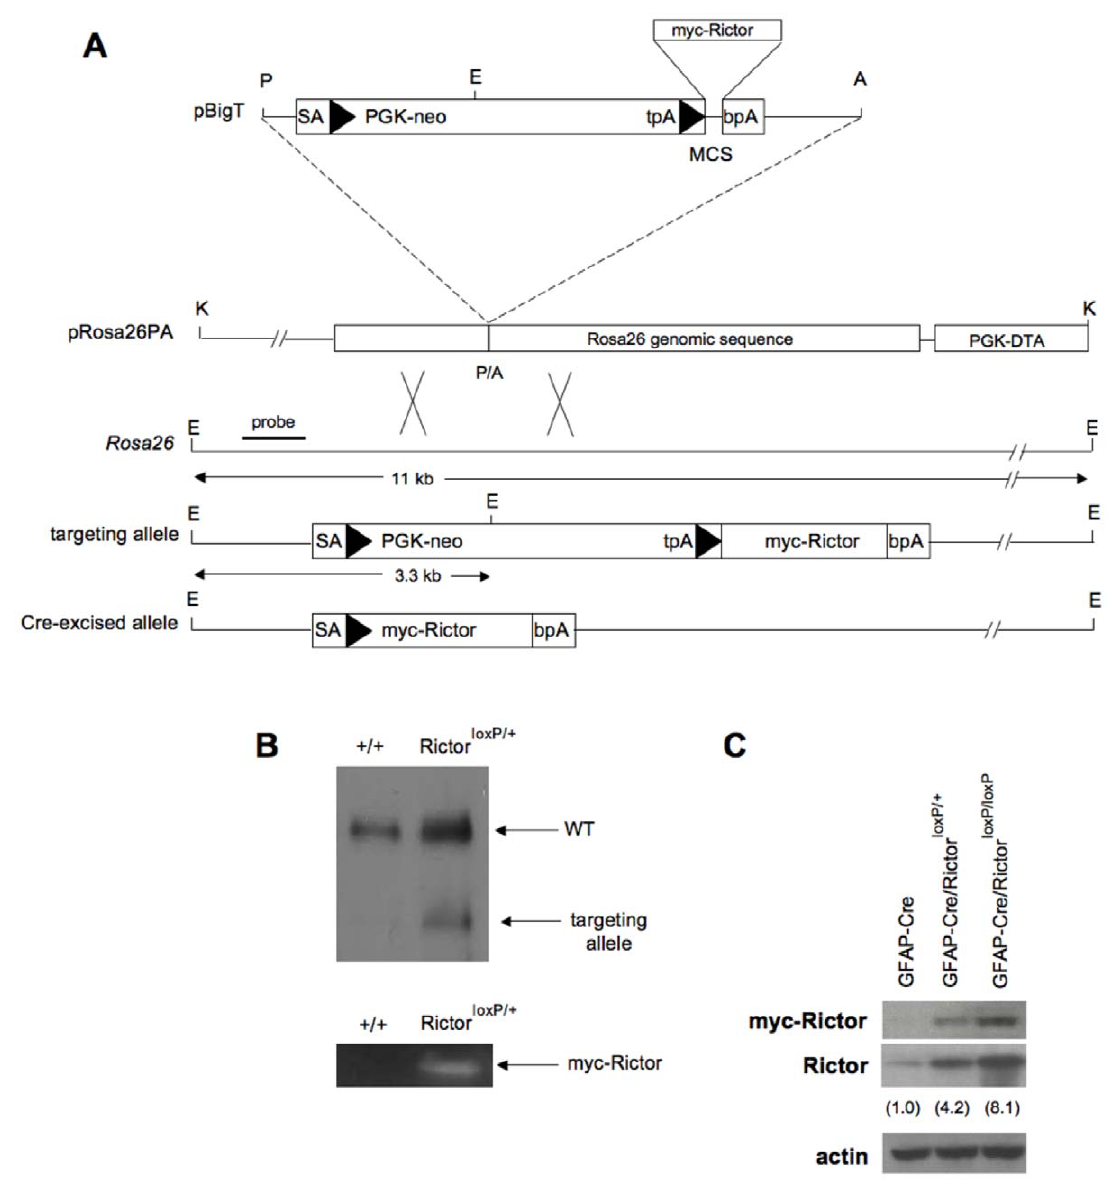
Figure 1. Generation of the ROSA26hRictor loxp/ + mice ( Rictor loxp/ + ) . (A) Targeting strategy for Rictor loxp/ + . A human myc-tagged Rictor sequence was cloned into the pBigT plasmid and subcloned into the targeting vector pROSA26PA. The predicted sizes of EcoRV (E) – digested DNA fragments are shown when hybridized to the indicated probe. (B). Southern blot of EcoRV-digested genomic DNA from + / + or Rictor loxp/ + mice hybridized to the probe shown in (A). In the lower panel, genomic PCR-based detection of the myc-Rictor transgene sequences is shown in + / + and Rictor loxp/ + mice. (C) Immunoblot of brain extracts from GFAP-Cre, GFAP-Cre/Rictor loxp/ + , or GFAP-Cre/Rictor loxp/loxp mice using antibodies against the myc-tagged Rictor demonstrating Cre-dependent expression of Rictor. Values in parentheses are fold increases in total Rictor expression relative to endogenous expression levels in GFAP-Cre mice as determined by densitometric analysis of an immunoblot using antibodies reactive to both human and murine Rictor.